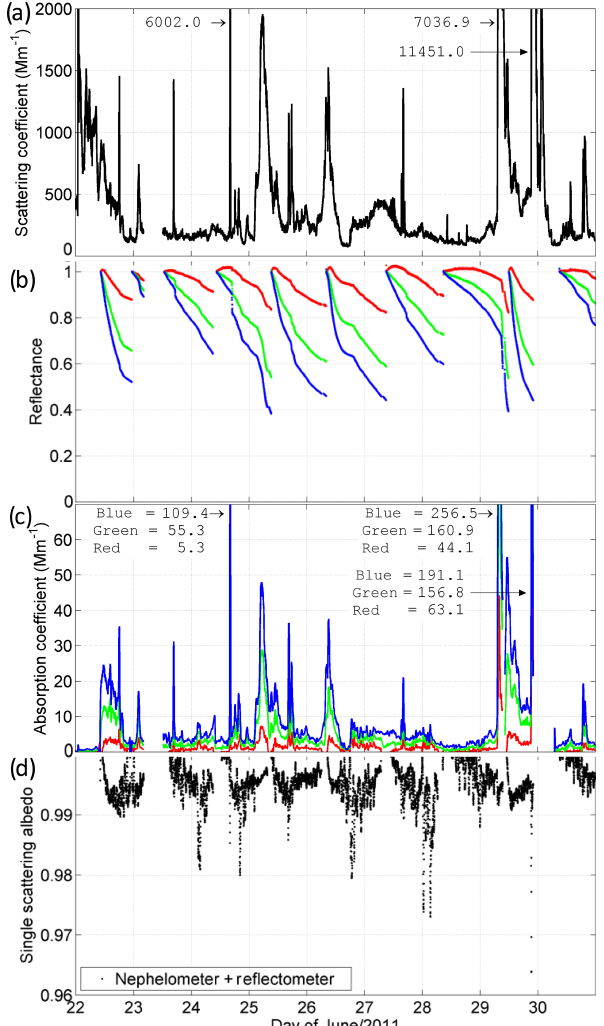
Figure 4. In situ measurements from SS1 in Algeria: (a) scatter- ing coefficient in Mm − 1 ; (b) reflectance measurements normalized with respect to a clean filter at three wavelengths, 450nm (in blue), 530nm (in green), and 670nm (in red); (c) derived absorption coef- ficient for the period of 22 to 30 June 2011; and (d) single scatter- ing albedo of the Saharan dust at 640nm calculated by combining the measurements of scattering and absorption coefficients from the nephelometer and the reflectometer, respectively. Uncertainties are discussed in Sect.